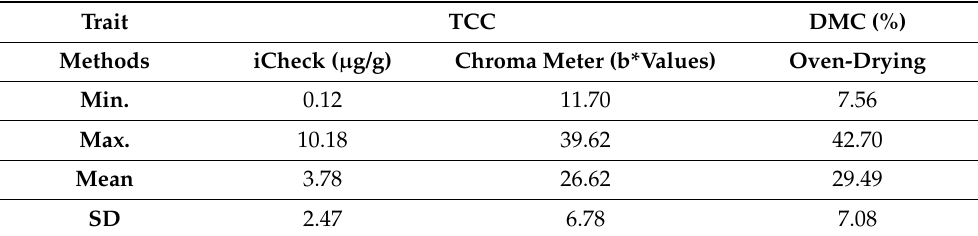
Table 1. Summary statistics of traits.